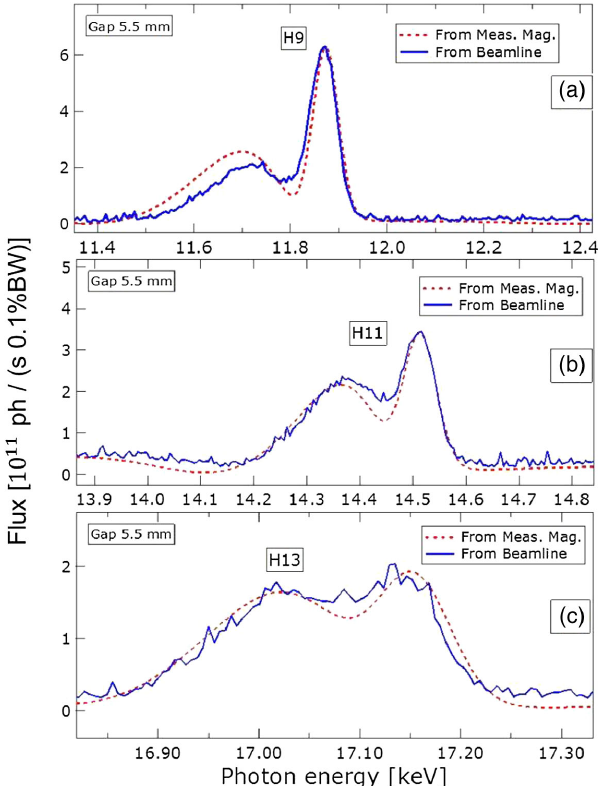
FIG. 21. Normalized spectra measured on the beam line (nonabsolute) and calculated from magnetic measurements at 5.5 mm gap through a 0 . 05 mm × 0 . 05 mm aperture at a distance of 20.3 m from the undulator. Electron beam parameters of ¼ 8 . 906 m, β ¼ 7 . 216 m, α ¼ − 1 . 296 rad, table II, with β x z x α ¼ − 1 . 477 rad. (a): 9th harmonic, (b): 11th, and (c): 13th z harmonic.